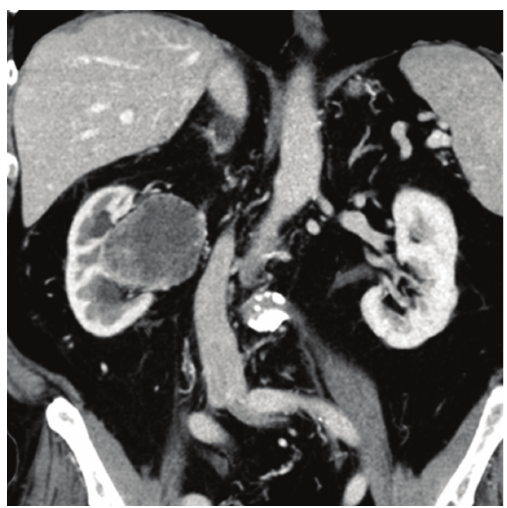
Figure 1: Contrast-enhanced CT abdomen and pelvis showing a tumour with central necrosis originating from the right renal pelvis and protruding into perirenal fat medially. There is slight dilatation of the superior and inferior calyces. Table 1: Total dose of chemotherapy drugs per square meter.